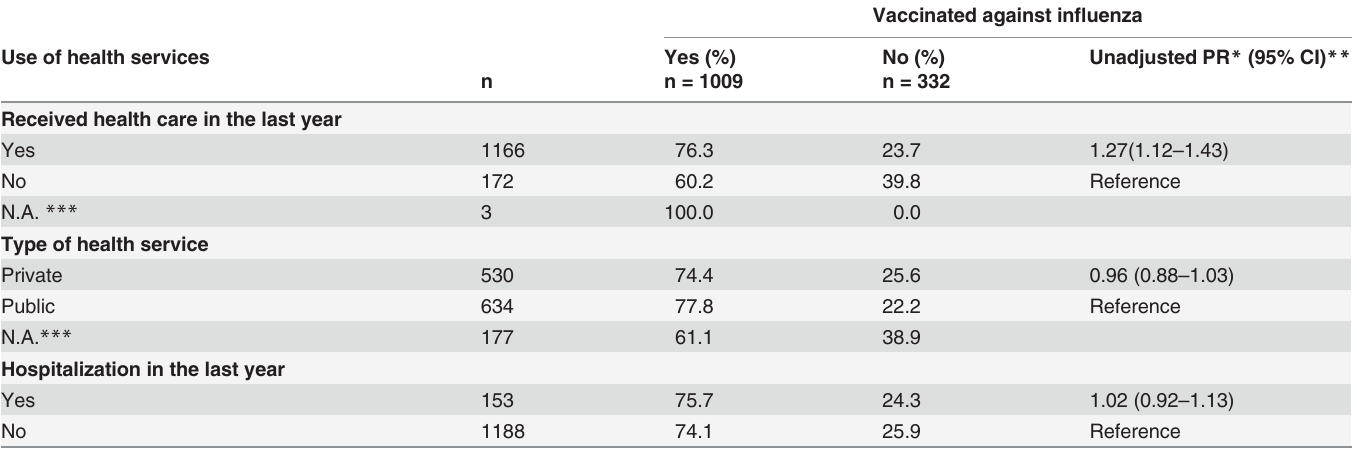
Table 4. Influenza vaccination among the elderly (n = 1,341) by use of health services during the last year. S ã o Paulo, Brazil,